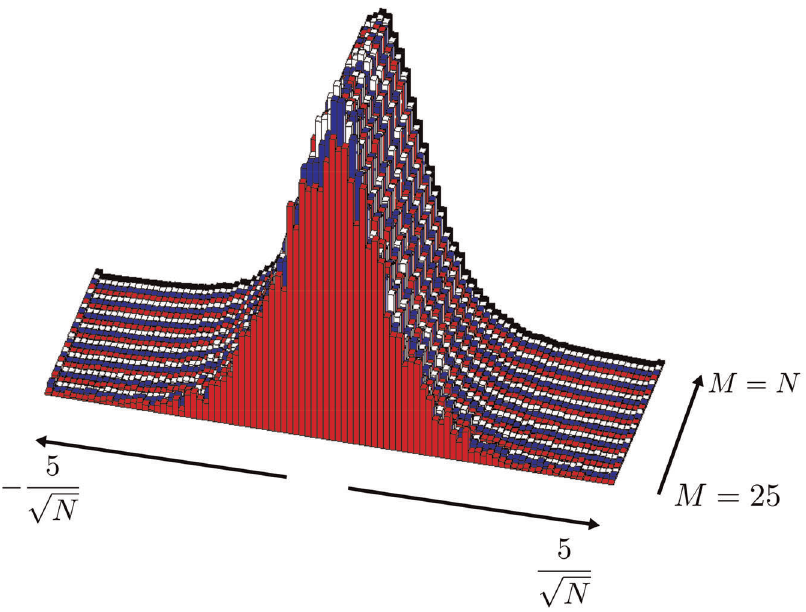
Figure 4. The distribution of the elements of S ~ VV , for equally spaced values of M . The eigenvectors ~ VV for a correlation matrix from simulations similar to those in figure 2 used to demonstrate the approximately Gaussian distribution for the elements of S ~ VV . The red distribution in the front is for M ~ 25 , and the black distribution in the back is for M ~ N , with intermediate layers corresponding to intermediate values. The S matrix was randomly initialized for each value of M